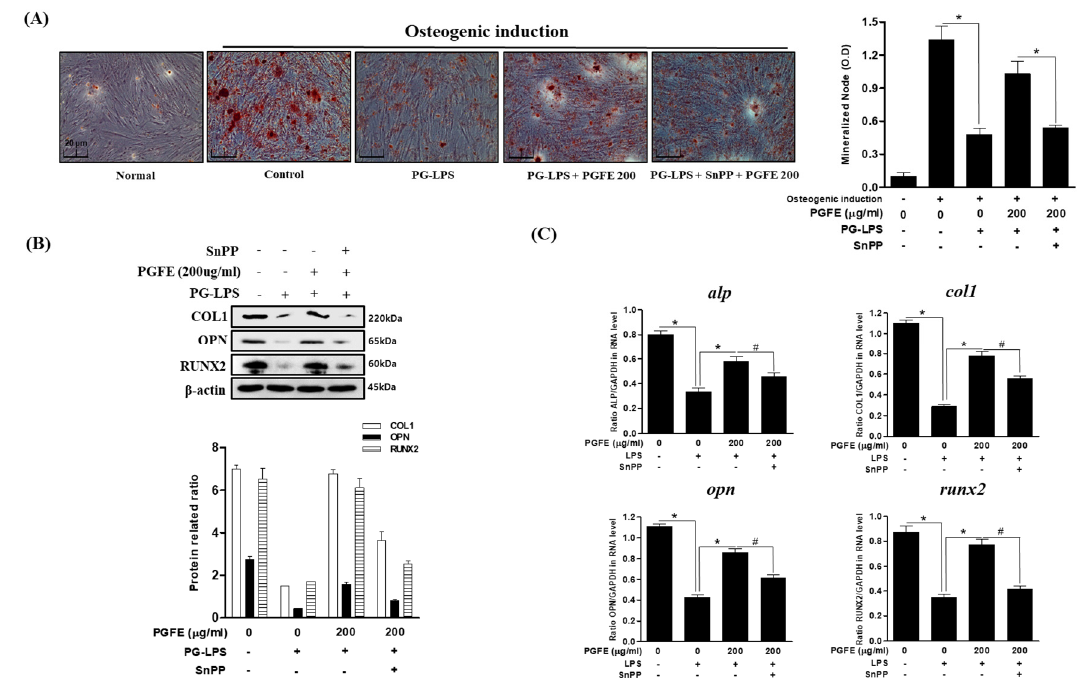
Figure 7. Effect of HO-1 expression by PGFE on osteogenic induction. ( A ) The PDL cells were pretreated with or without the indicated concentration of tin protoporphyrin IX (SnPP), then after, PGFE (200 µg/mL) for 6 h and then incubated with lipopolysaccharides (LPS) for 7 days. ( B ) The protein expressions were confirmed by Western blot analysis. ( C ) The mRNA levels of alp , col1, opn, and runx2 were measured by real-time PCR. The results were normalized to gapdh or β -actin expression. * p < 0.05 vs. only LPS treated group; # p < 0.05 vs. LPS + PGFE treated group. Scale bars denoted 20 µm.